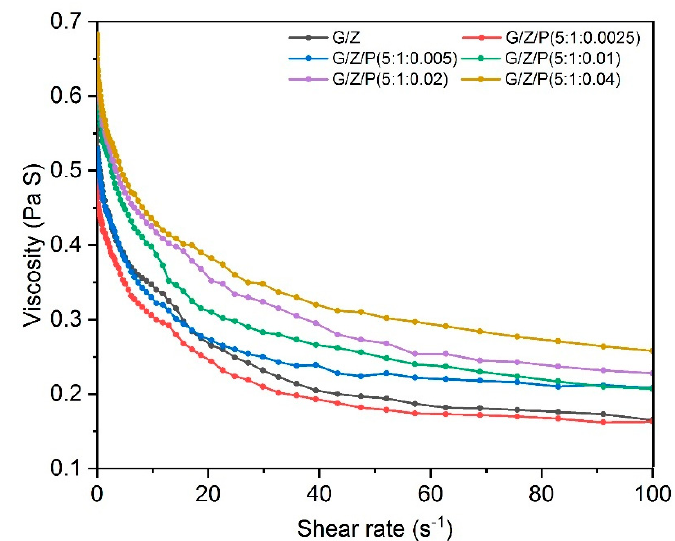
Figure 1. The viscosity of gelatin/zein solutions loaded with different concentrations of perillalde-